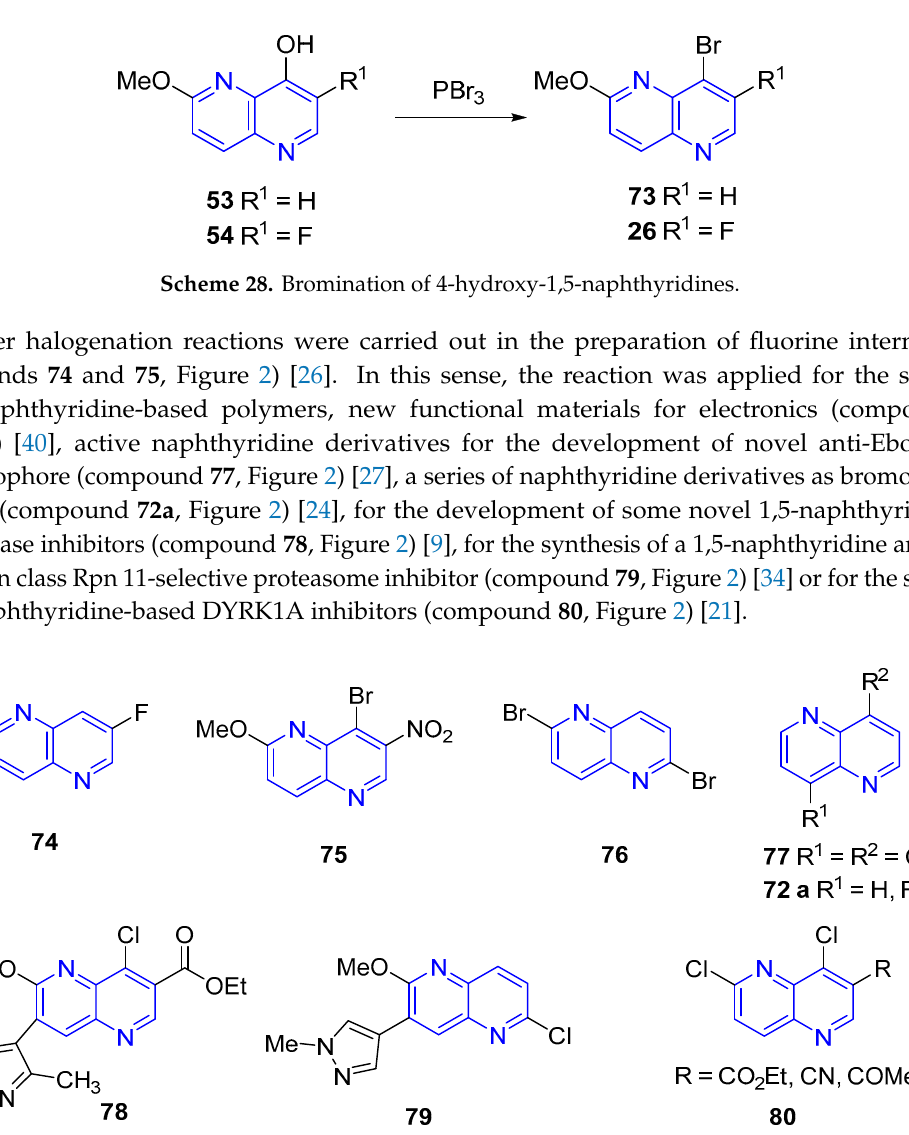
Figure 2. Compounds obtained by halogenation of hydroxy-1,5-naphthyridine